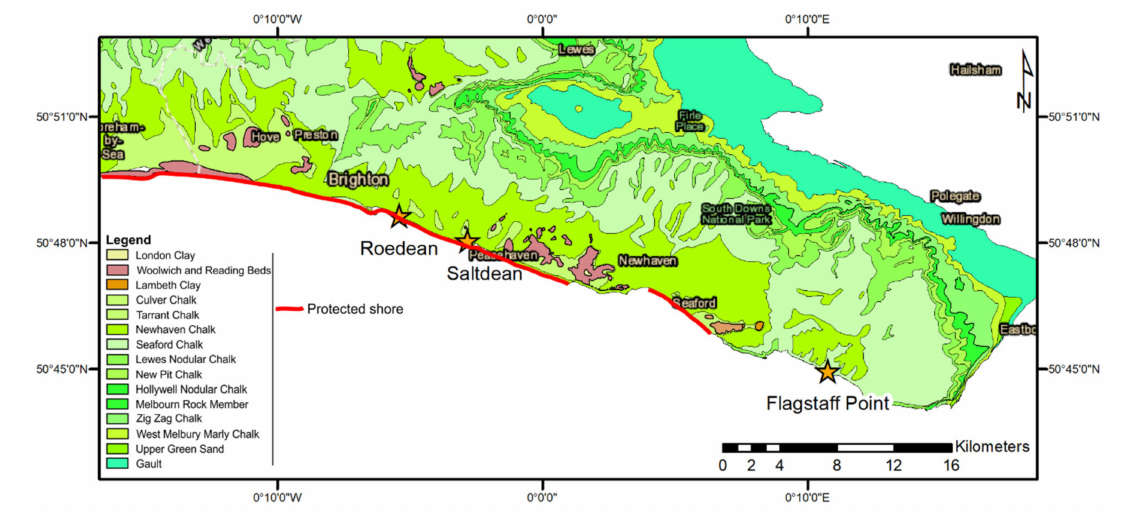
Figure 3. Bedrock geology of East Sussex, available on Edina DigiMap online (updated 2013 by BGS) with the protected areas of the shore marked in red (Service Layer Credits: Esri, HERE, Garmin, © OpenStreetMap contributors and the GIS User Community).